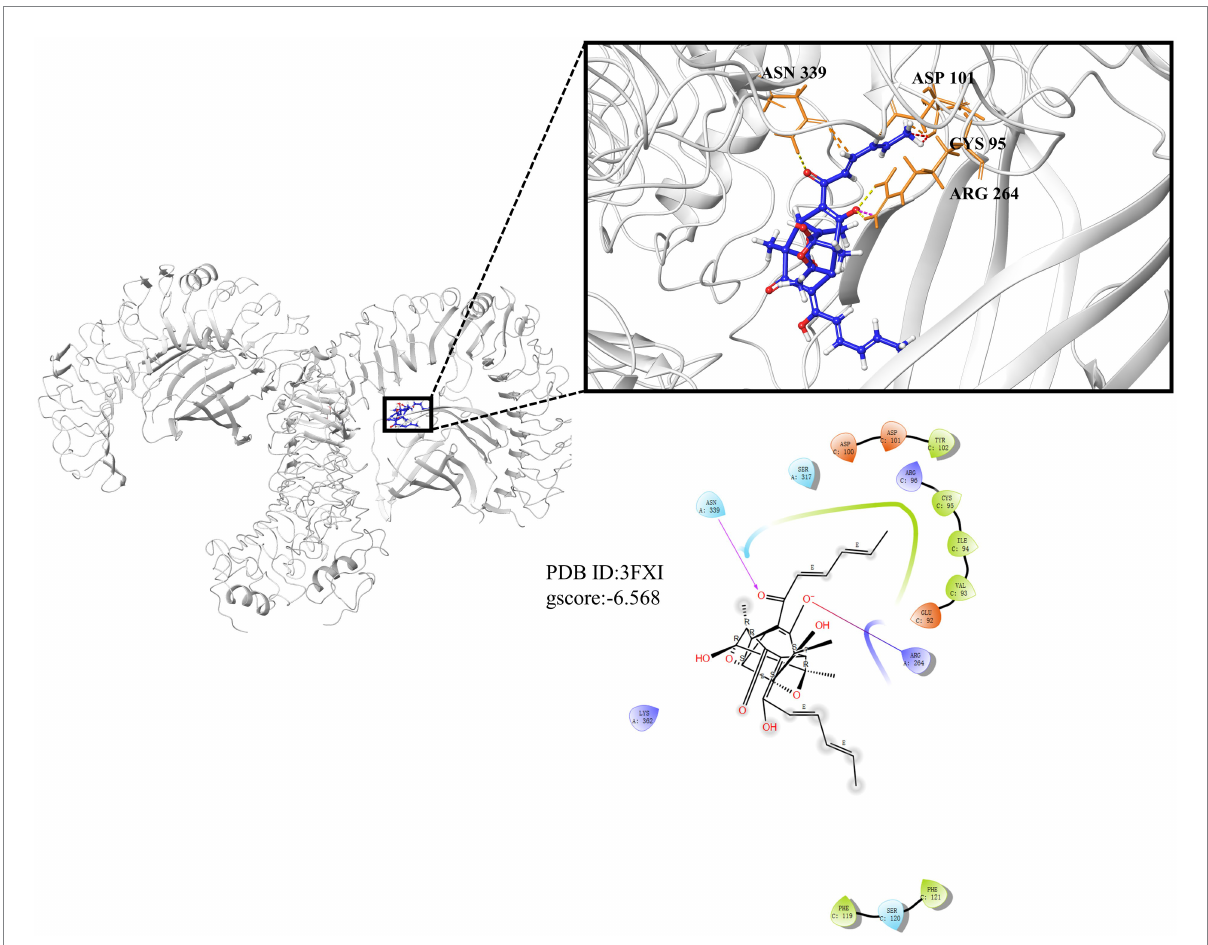
FIGURE 7 Molecular docking results of trichodimerol and TLR4-MD2. Molecular docking is simulated under the lowest energy conformation. Hydrogen bond interactions are represented by dotted